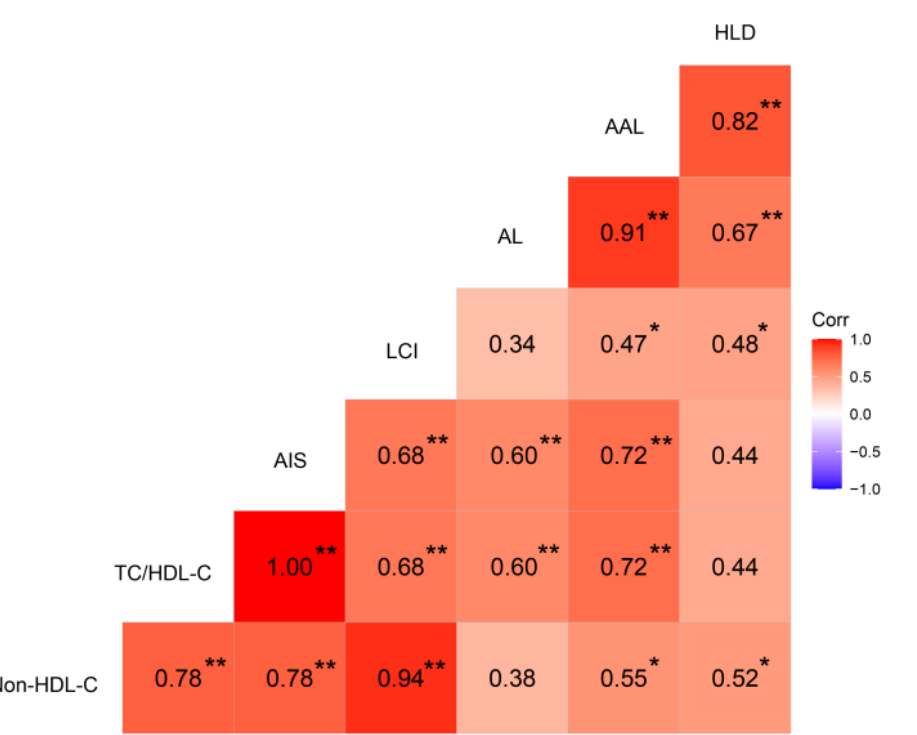
Figure 2. Heat map based on Pearson’s correlations for the relationship between nontraditional lipid parameters (AIS, LCI, etc.) and aortic lesion, aortic arch lesion, and hepatic lipid deposition in chickens. The color scale represents Pearson’s correlation coefficients, with red and bluish violet representing positive and negative correlations, respectively. Ranging from 1.0 (maximum positive correlation) to − 1.0 (maximum anti-correlation), with 0 indicating no correlation. Non-HDL-C, non-HDL-C = TC − HDL-C; TC, total cholesterol; HDL-C, high-density lipoprotein cholesterol; AIS, AIS = (TC − HDL-C)/HDL-C; LCI, LCI = TC × TG × LDL-C/HDL-C; TG, triglyceride; LDL-C, low-density lipoprotein cholesterol; AL, aortic lesion; AAL, aortic arch lesion; HLD, hepatic lipid deposition. * p < 0.05, ** p <